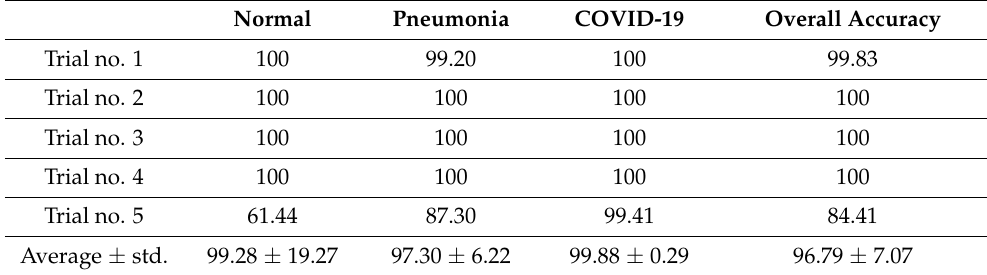
Table 3. Accuracy per class (%) of the EfficientNet-B2 model with a transfer learning approach. We present the results of the five trials, where each trial is an experiment of the 5-fold cross-validation procedure. The last column represents the overall accuracy of the model.